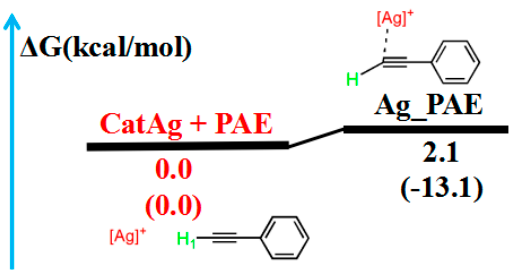
Figure 1. Reaction pathway of the addition reaction between catalyst CatAg and PAE. The relative free energy of the reaction pathway involving hydrogen is provided in kcal/mol. The relative enthalpy is also provided in brackets for reference (in